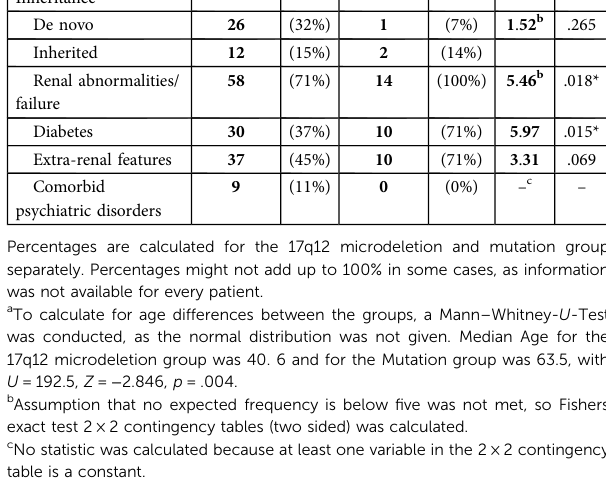
table is a constant. * p <0.05,